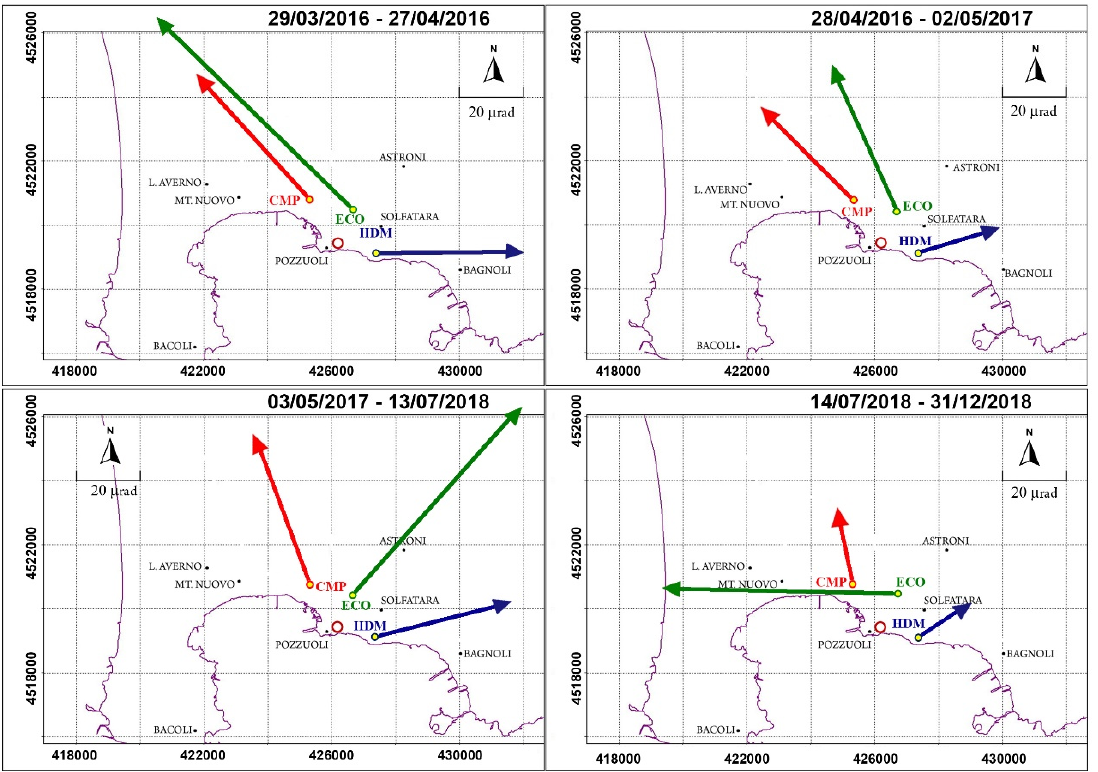
Figure 4. Tilt direction patterns observed at each borehole station during the four Time Intervals discussed in the text and showed in Figure 3. Tilt vectors point outwards from the area of maximum uplift (shown with a red circle).